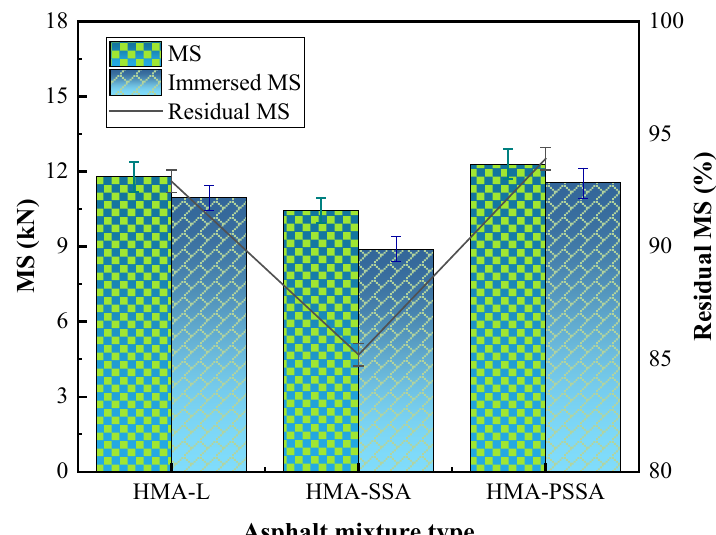
Figure 17. Immersion Marshall test results.